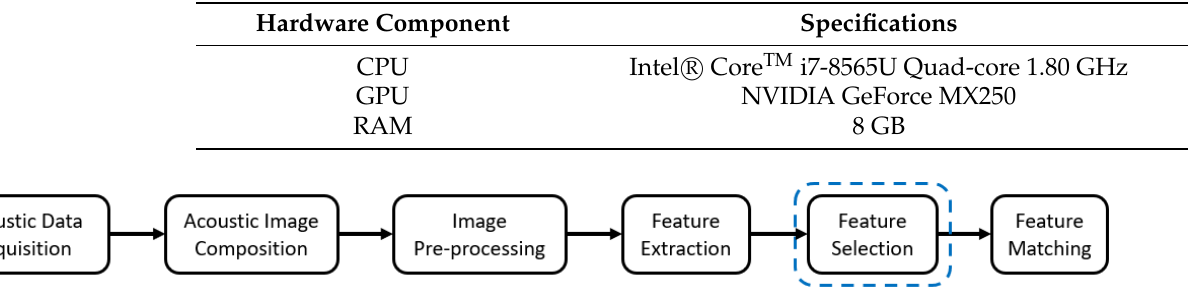
Figure 8. Inclusion of the filtering layer (highlighted in blue) into the image analysis procedure.